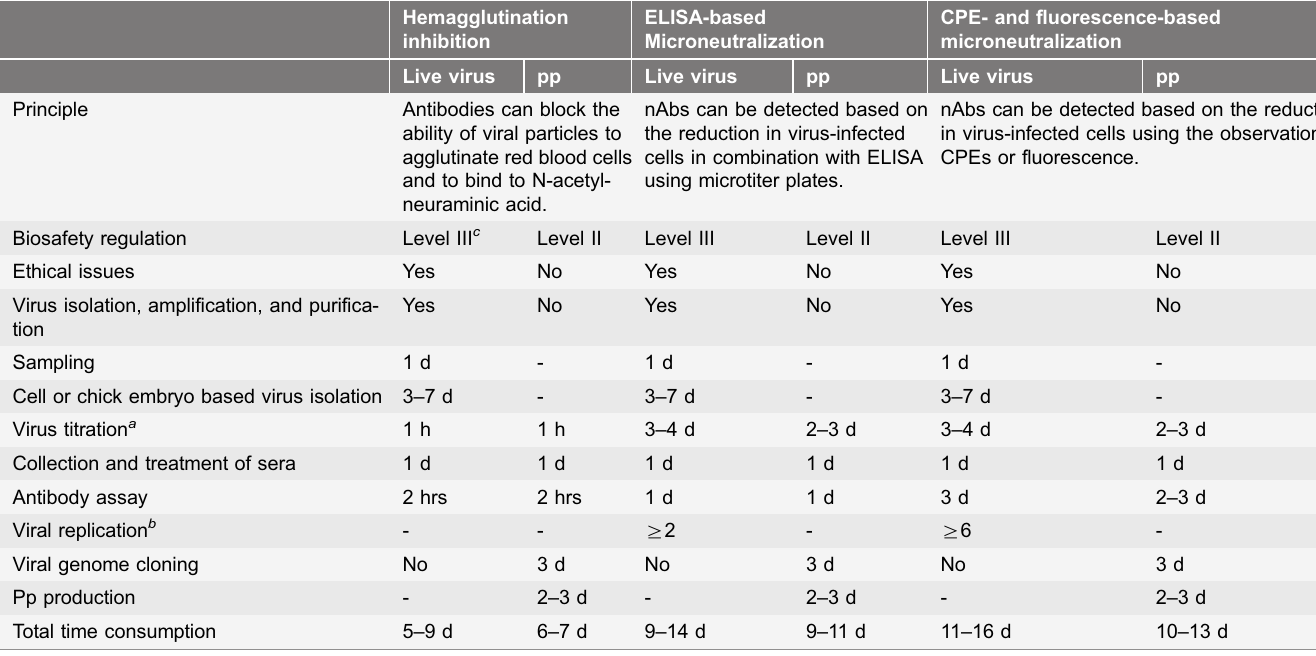
Table 4. Comparison of live virus versus